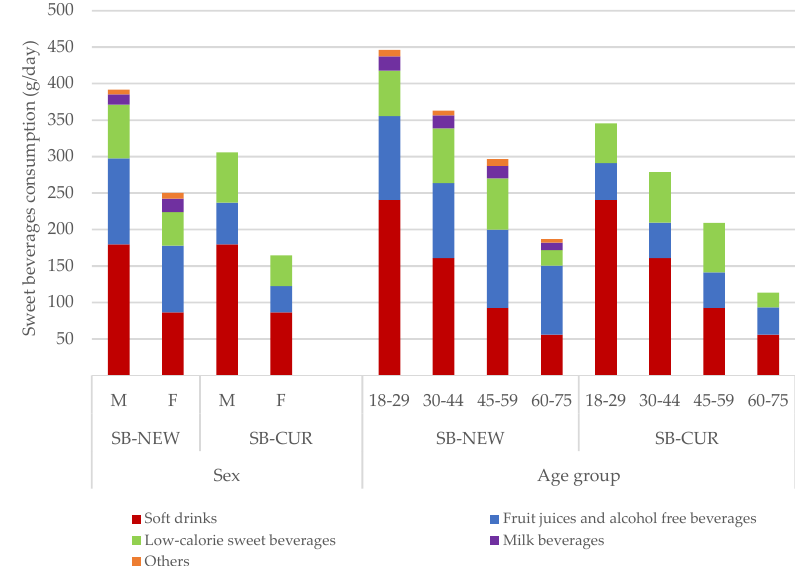
Figure 2. Weighted average consumption of sweet beverages (g/day) SB–NEW vs. SB–CUR by sweet beverage category and by sex and age group. SB–NEW includes all beverages. SB–CUR excludes 100% juices (no added sugar), milk beverages, and other beverages, with added sugar or sweetener, as defined in Table 1. All results were weighted for sex, age, marital status, major area of Switzerland, nationality, and household size. Differences in the means between SB–CUR and SB–NEW by all stratifiers and within stratifiers were statistically significant with ANOVA ( p < 0.001).